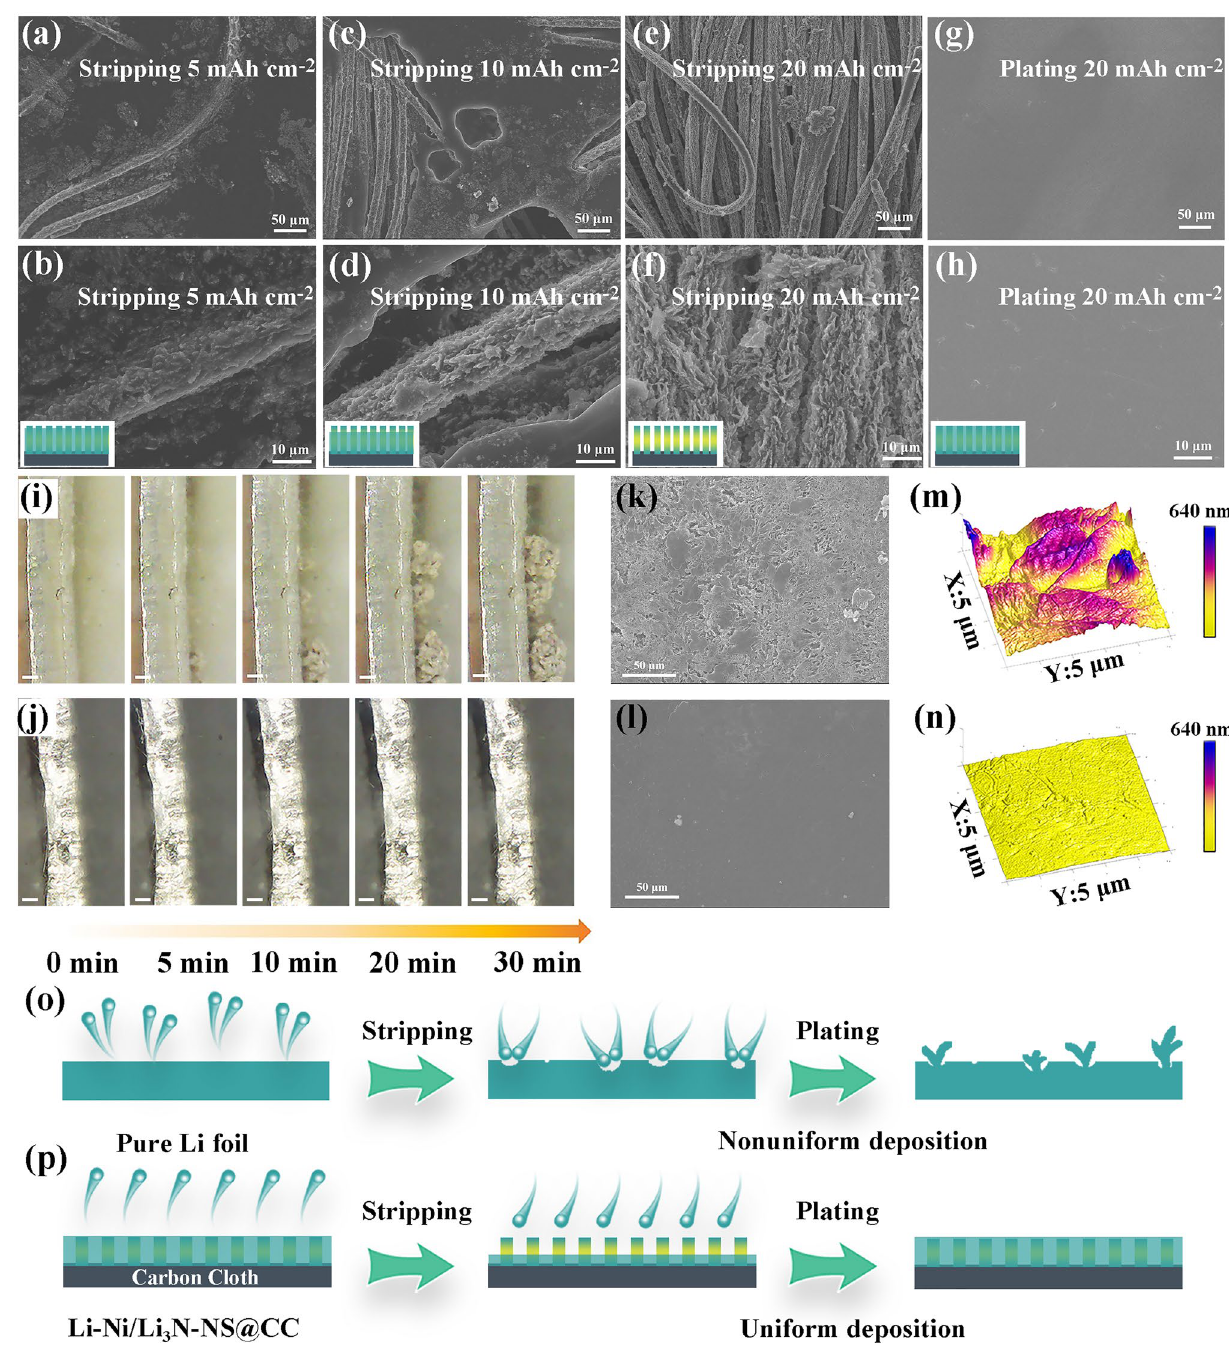
Fig. 5 SEM images of the Li-Ni/Li 3 N-NS@CC electrode after stripping a , b 5 mAh cm −2 , c , d 10 mAh cm −2 , e , f 20 mAh cm −2 and replating g , h 20 mAh cm −2 . Operando observation of the Li plating on i pure Li and j Li-Ni/Li 3 N-NS@CC electrode and the scale bar is 100 µm. SEM images of k pure Li and l Li-Ni/Li 3 N-NS@CC electrodes after 20 cycles at 5 mA cm −2 and 5 mAh cm −2 . AFM images of m pure Li and n the Li-Ni/Li 3 N-NS@CC electrodes after cycling, respectively. Schematic illustration of the Li stripping/plating behavior of o pure Li foil and p the Li-Ni/Li 3 N-NS@CC